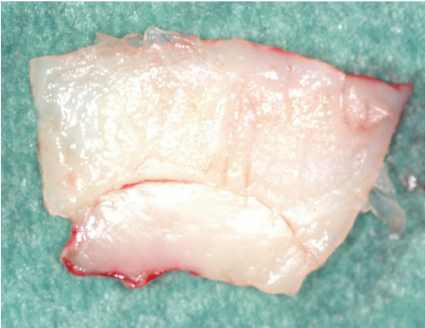
Figure 15: First provisional crown in situ. After a 2-month healing time, the soft tissue profile was still unaesthetic when compared to the contralateral side.